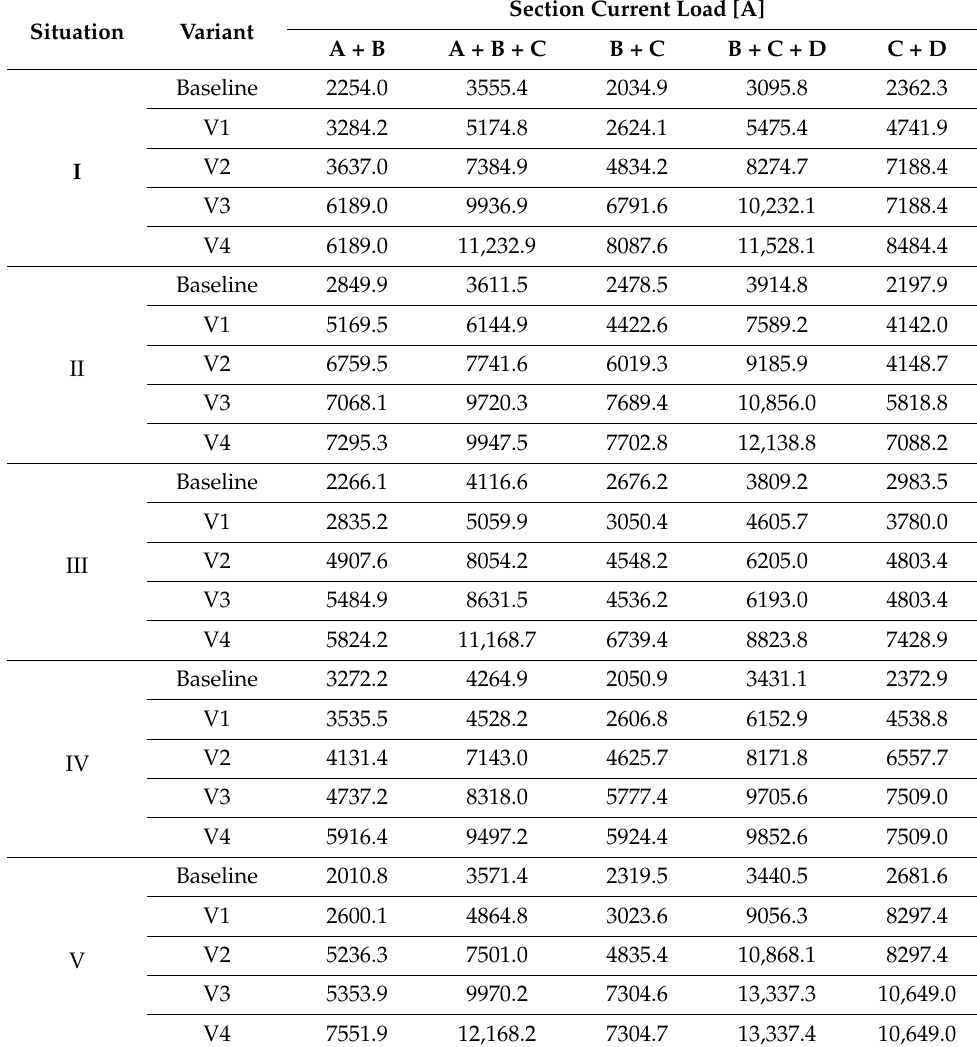
Table 4. Results of a